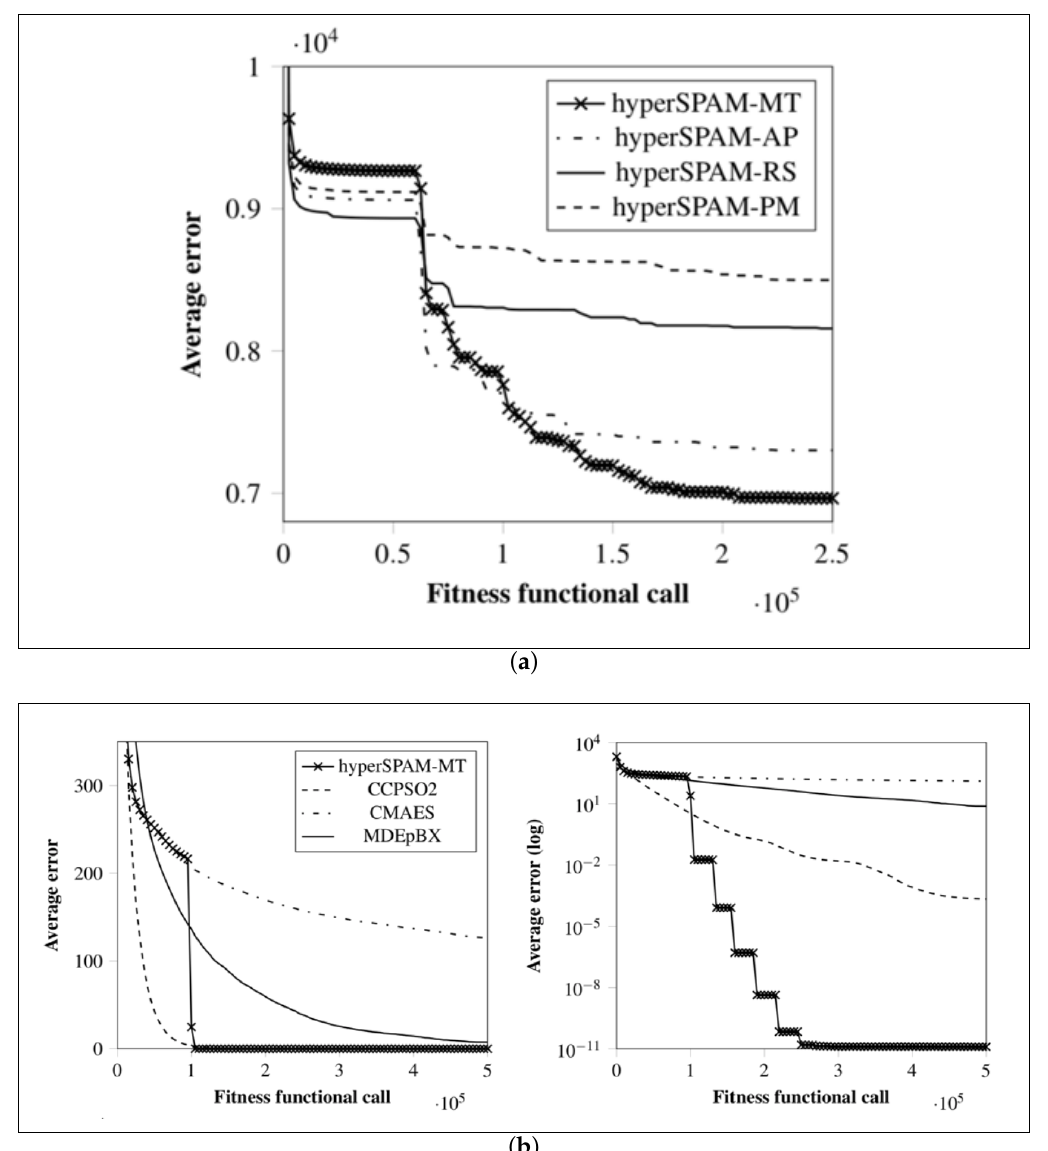
Figure 8. Example of average error trends produced with SOS for the study in [24]. In ( a ), the full image with the caption. In ( b ), a further example of an average error trend from the same study, plotted in both linear and logarithmic scale. More examples from several other studies were gathered in